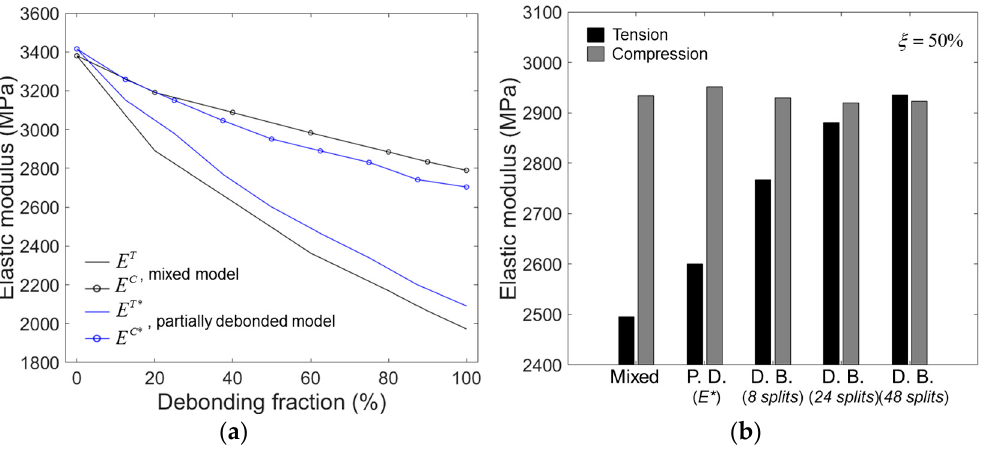
ξ Figure 10. ( a ) Elastic moduli as a function of for the mixed and partially debonded models. ( b ) Figure 10. ( a ) Elastic moduli as a function of ξ for the mixed and partially debonded models. ξ ( b ) Compressive and tensile moduli for ξ = 50%, obtained by different models. The abbreviations used Compressive and tensile moduli for = 50%, obtained by different models. The abbreviations used are: P.D. (partially debonded) and D.B. (discontinuously are: P.D. (partially debonded) and D.B. (discontinuously bonded).